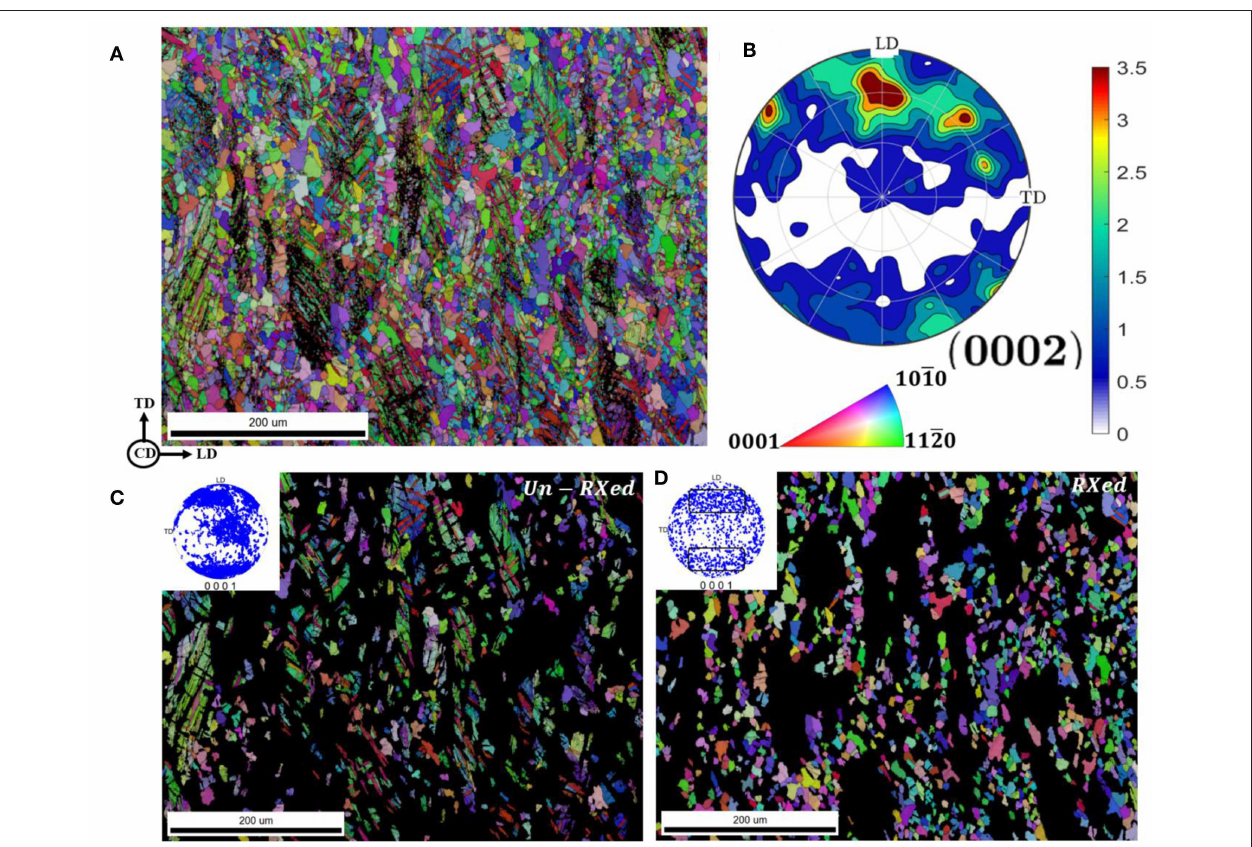
FIGURE 9 | EBSD map at 350 ◦ C (60min annealing time) indicating a partially recrystallized microstructure, (A) inverse pole figure map, (B) recalculated (0002) pole figure, (C,D) show the recrystallized and un-recrystallized subsets. Corresponding single orientation scatter for recrystallized and un-recrystallized regions are shown as inset plots on the top left